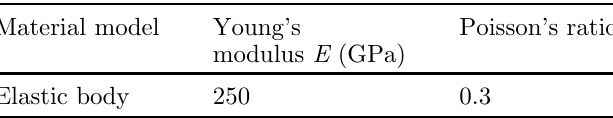
Table A.1. Mechanical properties of DLC texture